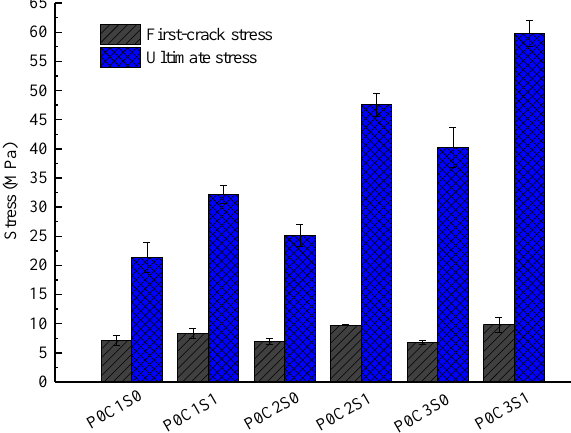
Figure 7. Load-deflection curves of the TRC specimens with different number of textile layers.